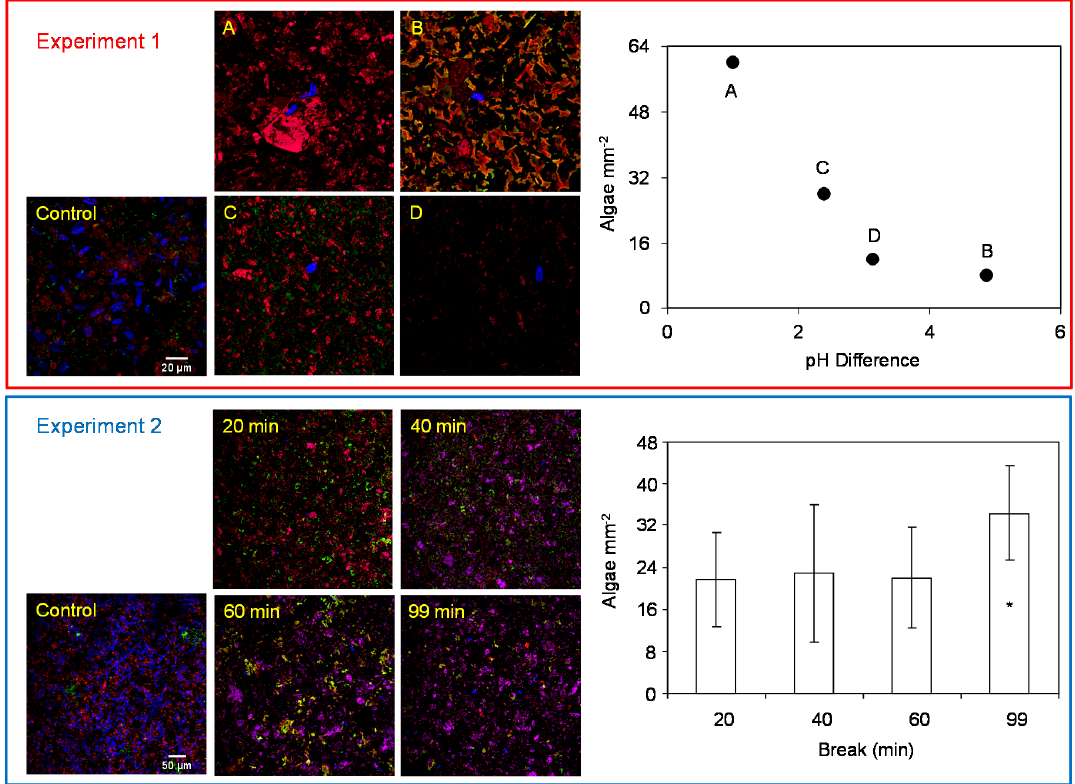
Figure 2. Left side: maximum intensity projections of CLSM data sets from biofilms after two weeks incubation: on the control pair of plates with Varnish A without electrolysis current and four paints (Experiment 1; red frame) and on the control and paint with four break times (Experiment 2; blue frame). Colour allocation: blue—autofluorescence of chlorophyll a , green—bacteria, red—lectin-specific EPS glycoconjugates. Right side: Algal density on the four paints, A–D (Experiment 1), as a function of the pH difference at the paint surfaces and on Paint A at different break times (Experiment 2; error bars: SD of ten images). The asterisk indicates a significant difference.